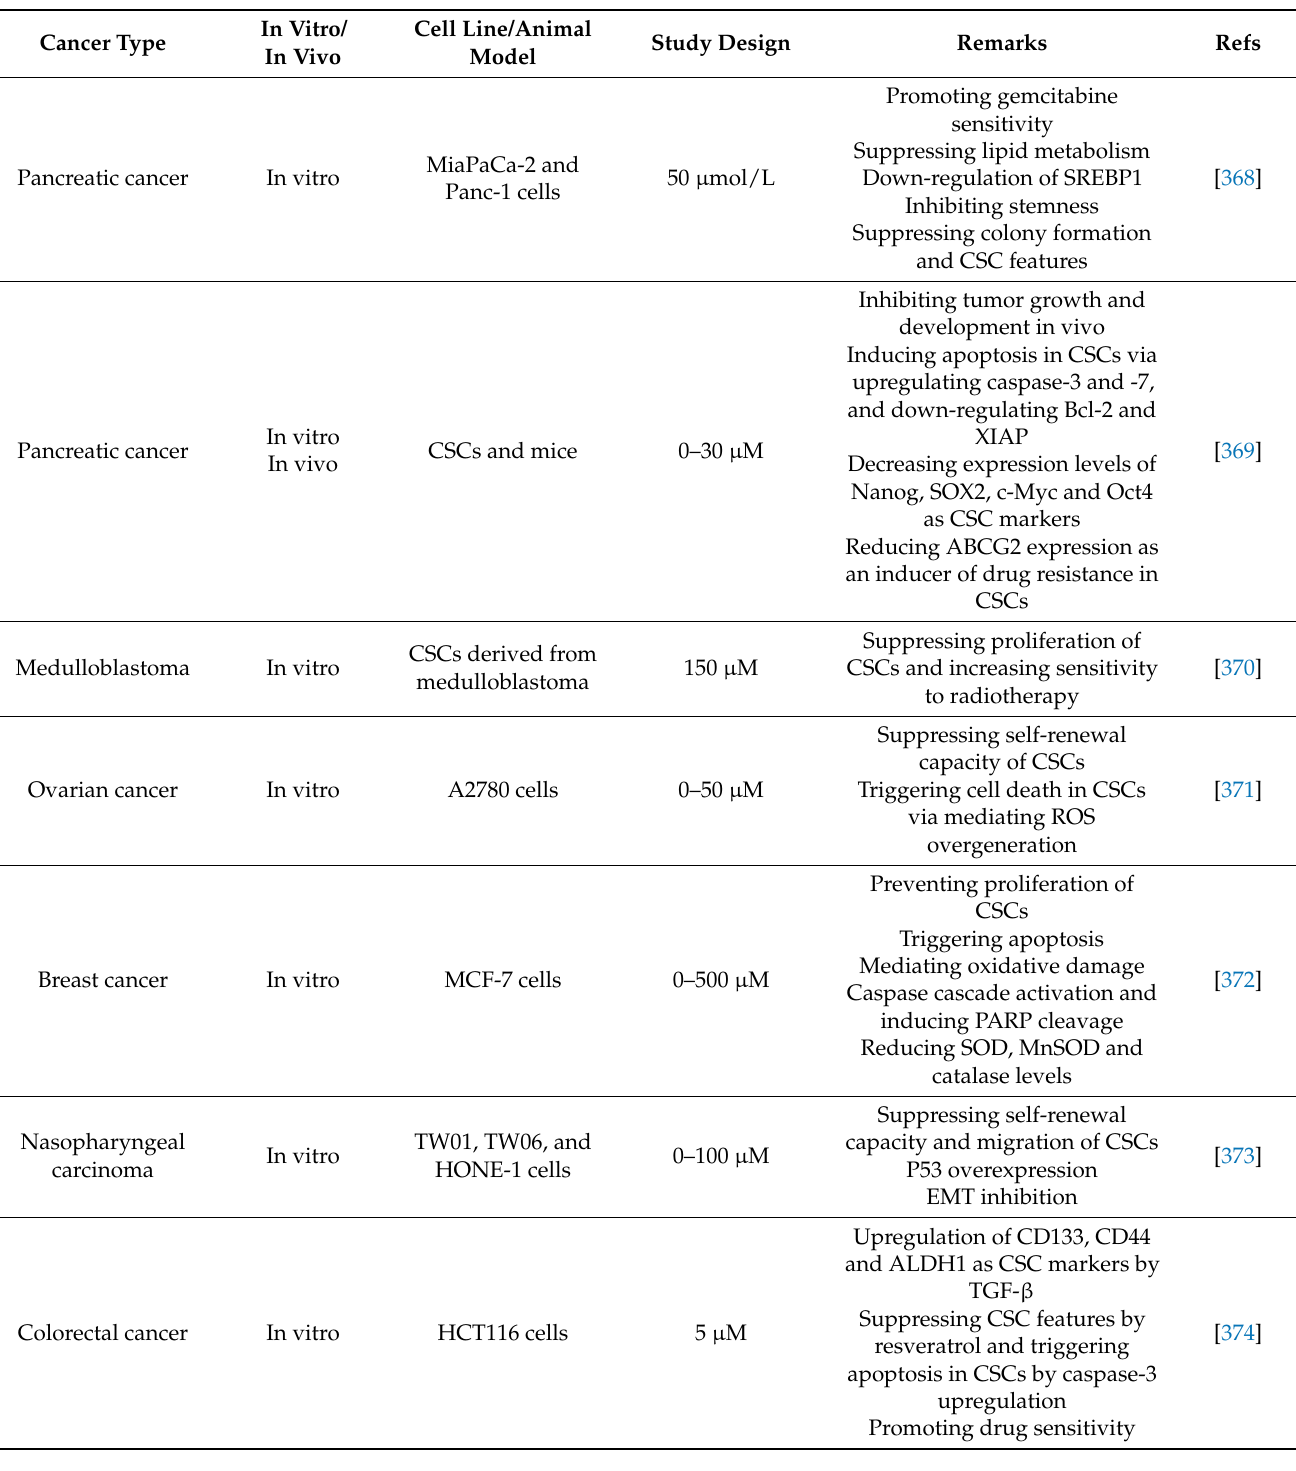
Table 7. Determining resveratrol potential in targeting CSCs and suppressing tumor